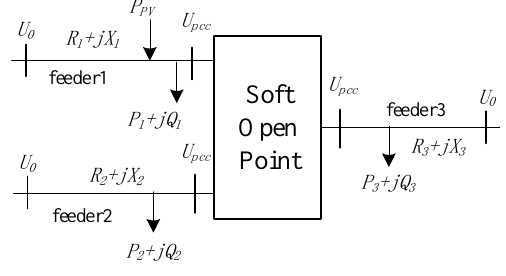
Figure 3. Soft open point access network.